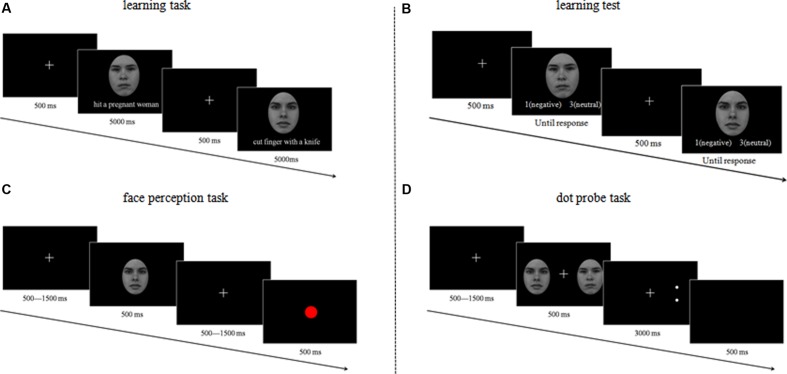
The procedure and design used in the various tasks and phases.